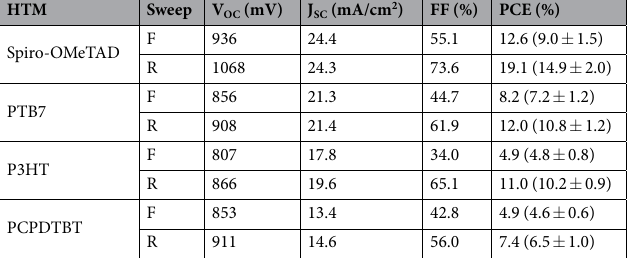
HTM Sweep V OC (mV) J SC (mA/cm 2 ) FF (%) PCE (%)